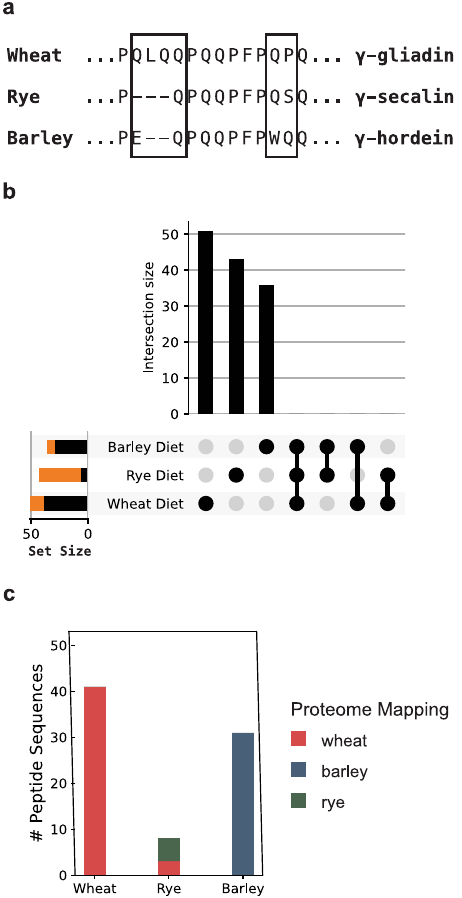
Fig. 3 LC – MS/MS analysis of urine from two healthy participants challenged with dietary wheat, rye, and barley. a Illustration of sequence differences between closely related gliadin, secalin, and hordein proteins from wheat, rye, and barley, respectively. The boxes highlight source- speci fi c sequence regions. b All possible intersections of the three sets of peptide sequences identi fi ed after the grain challenges are depicted as an UpSet plot 60 . The individual set size is plotted to the left of each row, with the black portion of the bar representing sequences that map uniquely to the respective dietary challenge proteome, and the orange portion representing those that do not. There are no intersections between these sets of peptides, suggesting the peptides depicted in orange are nonetheless likely to have originated from the speci fi c grain used for the dietary challenge. c Number of distinct peptide sequences uniquely mapping to the wheat, barley, and rye proteomes following dietary challenges. Sequences that mapped to more than one of the proteomes were excluded from this fi gure. In the rye diet, sequences mapping uniquely to the wheat proteome were only found in the rye diet, suggesting they are yet unannotated rye peptides. A full list of observed peptide sequences and their respective proteome mappings is provided in Supplementary Dataset 5. Participants in this experiment were males, ages 27 and 28. Source data are provided as a Source Data fi le. antibodies, which speci fi cally recognize the amino acid motifs QPQLP(Y/F) and QLP(Y/F)PQP, respectively 36 . Samples ( n = 4) from patients reporting adherence to a GFD and in which the measured gluten peptide concentrations were below the lateral fl ow assay limit of quanti fi cation were analyzed as negative con- trols. In accordance with the lateral fl ow results, we did not measure peptides mapping to the wheat proteome by LC – MS/MS.